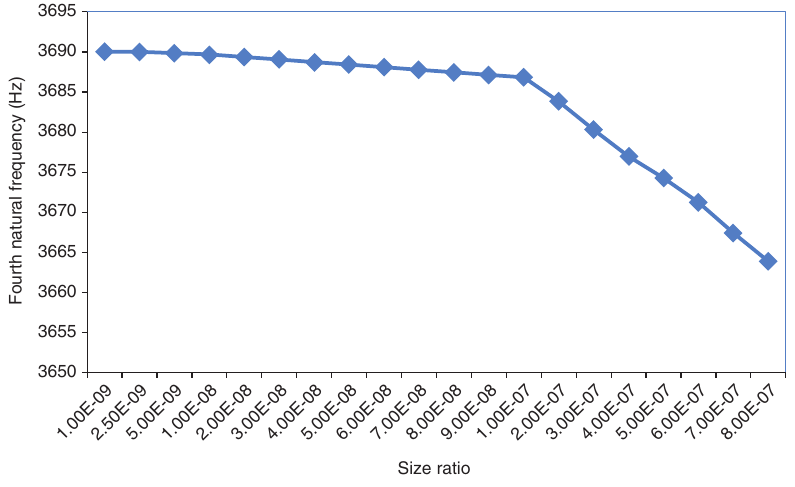
Figure 16: Variations of the fourth natural frequency of the cantilever beam with size ratio.